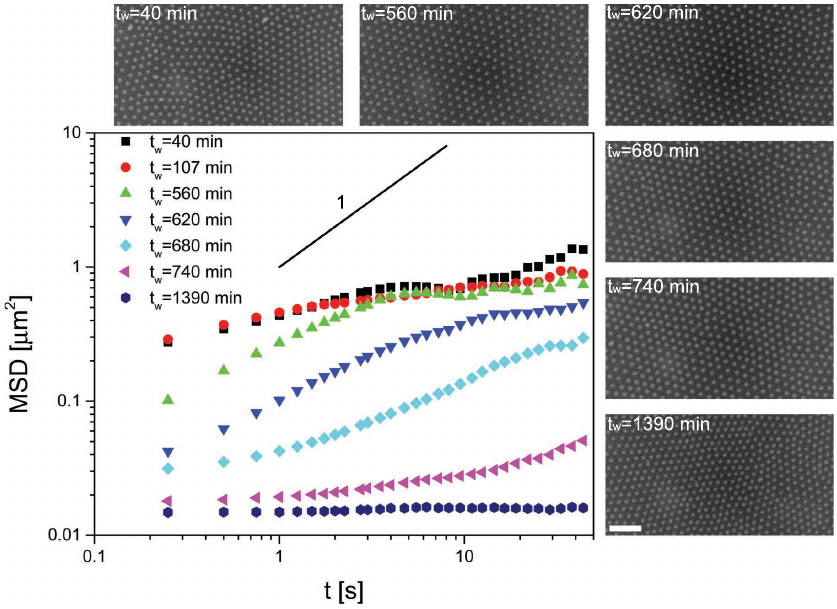
Figure 3. MSD versus time for 1.08 µ m PS particles at the water–decane interface as a function of residence time at the interface t w . A solid line with slope one representative of freely diffusive motion is included for comparison. The micrographs show the interface microstructure at various waiting times. The scale bar is 10 µ